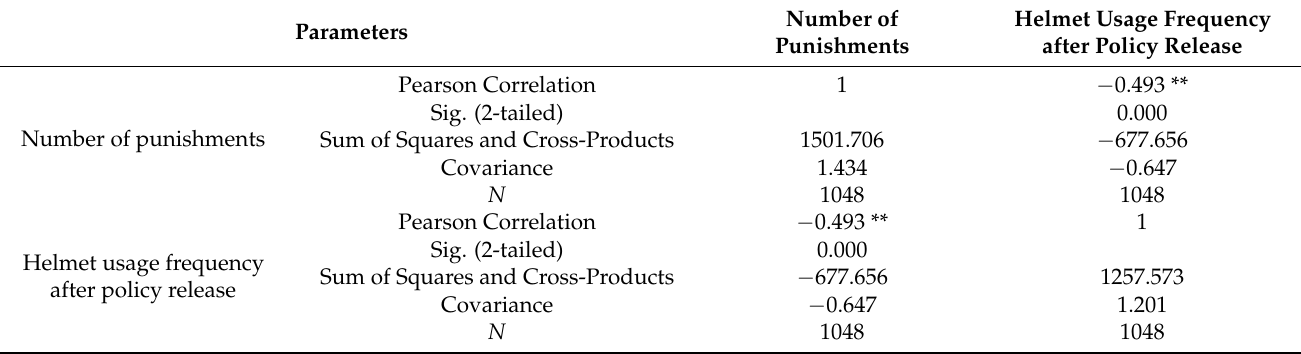
Table 9. Correlations